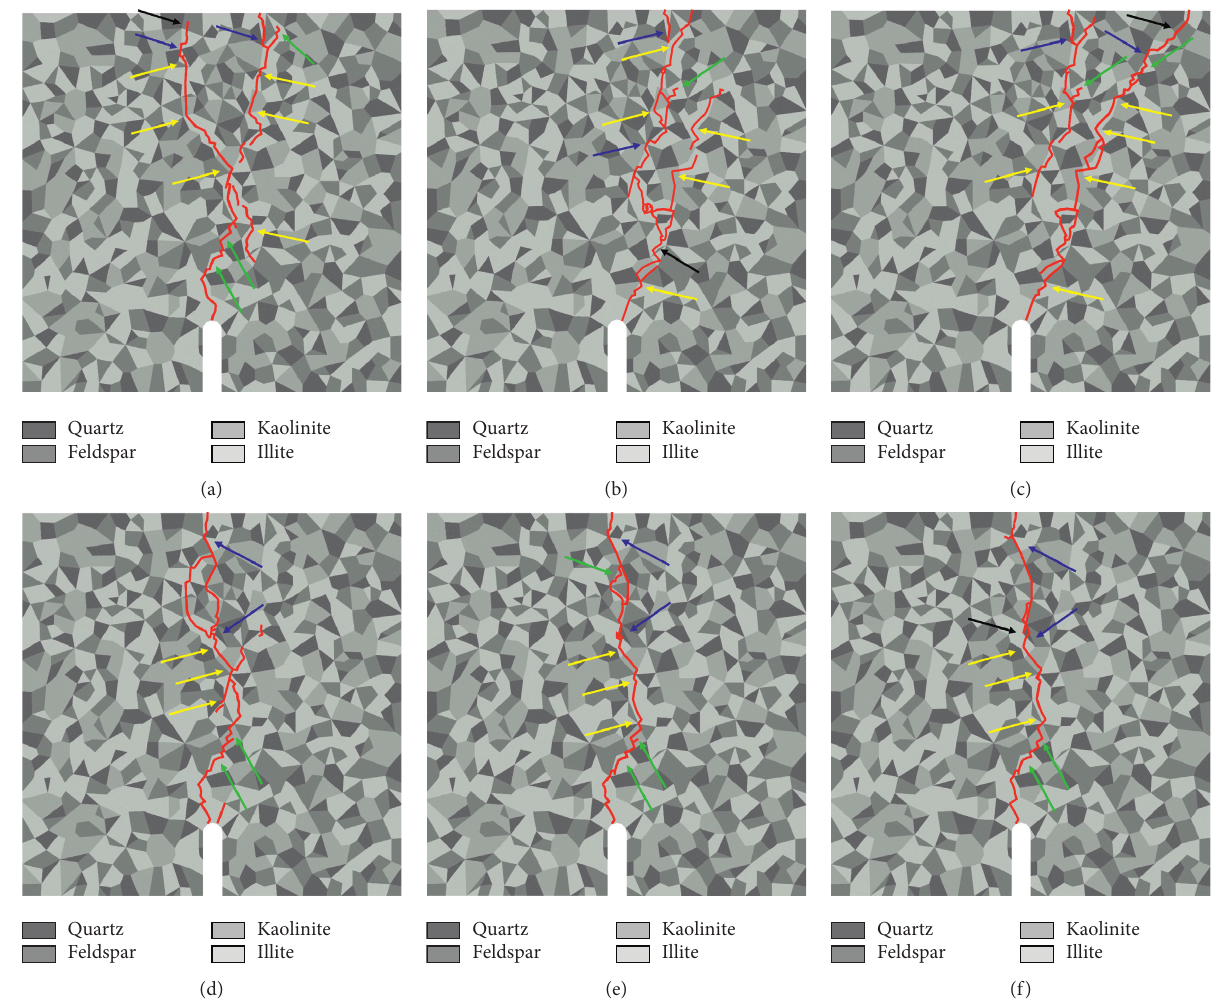
Figure 6: Continuous growth and deflection of cracks (in red) under six different loading methods. The yellow arrows refer to crack growth in large scales of kaolinite and illite, the green arrows refer to crack growth in smaller scales of kaolinite and illite surrounded by quartz and feldspar, the blue arrows show crack growth in the boundary between different minerals, and the black arrows refer to crack growth in quartz and